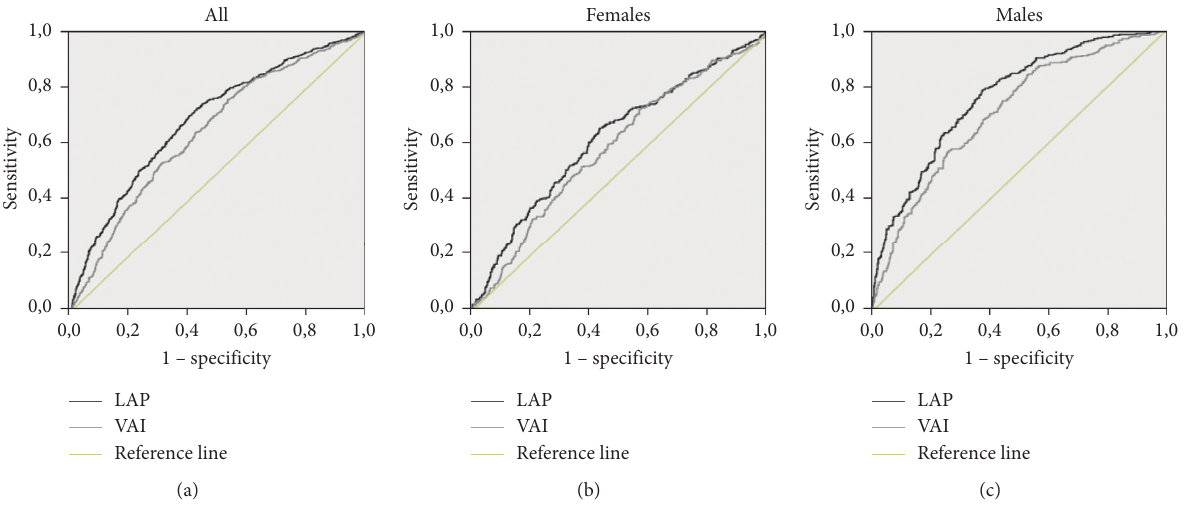
Figure 1: ROC curves of LAP and VAI for insulin resistance (Maracaibo, Venezuela). LAP: lipid accumulation product; VAI: visceral adiposity index.